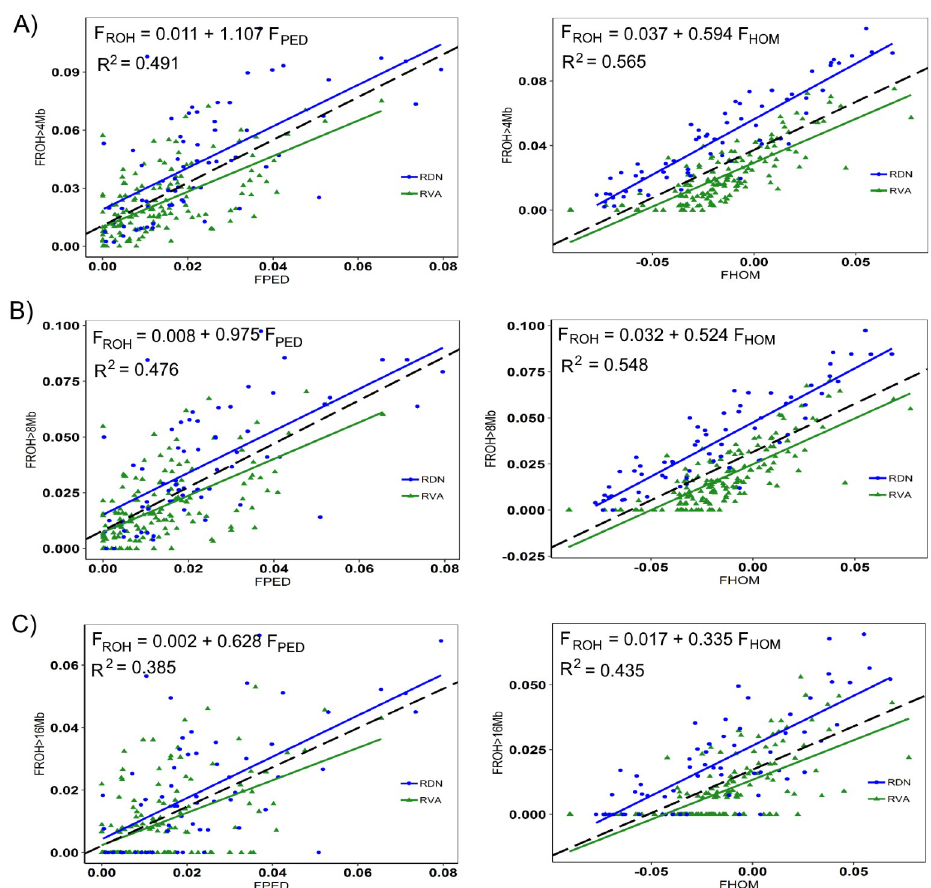
Fig 4. Regression plot of FROH > 4Mb (A), F ROH > 8Mb (B) and F ROH > 16Mb (C) on F PED (left) and on F HOM (right) for Angler (green) and Red-and-White dual-purpose (blue). The broken line (black) is a regression line for both breeds and corresponds to the regression equation